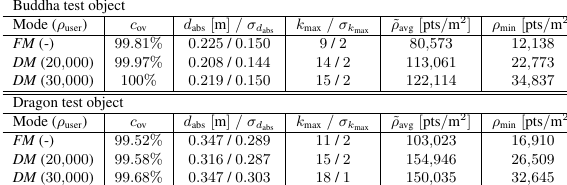
Table 3. Results for the Buddha test object (top) and the Dragon test object (bottom) with the “naive random” approach: the tables show the E P and the minimal point density ρ min listed by the modes, for two different user densities in the DM .